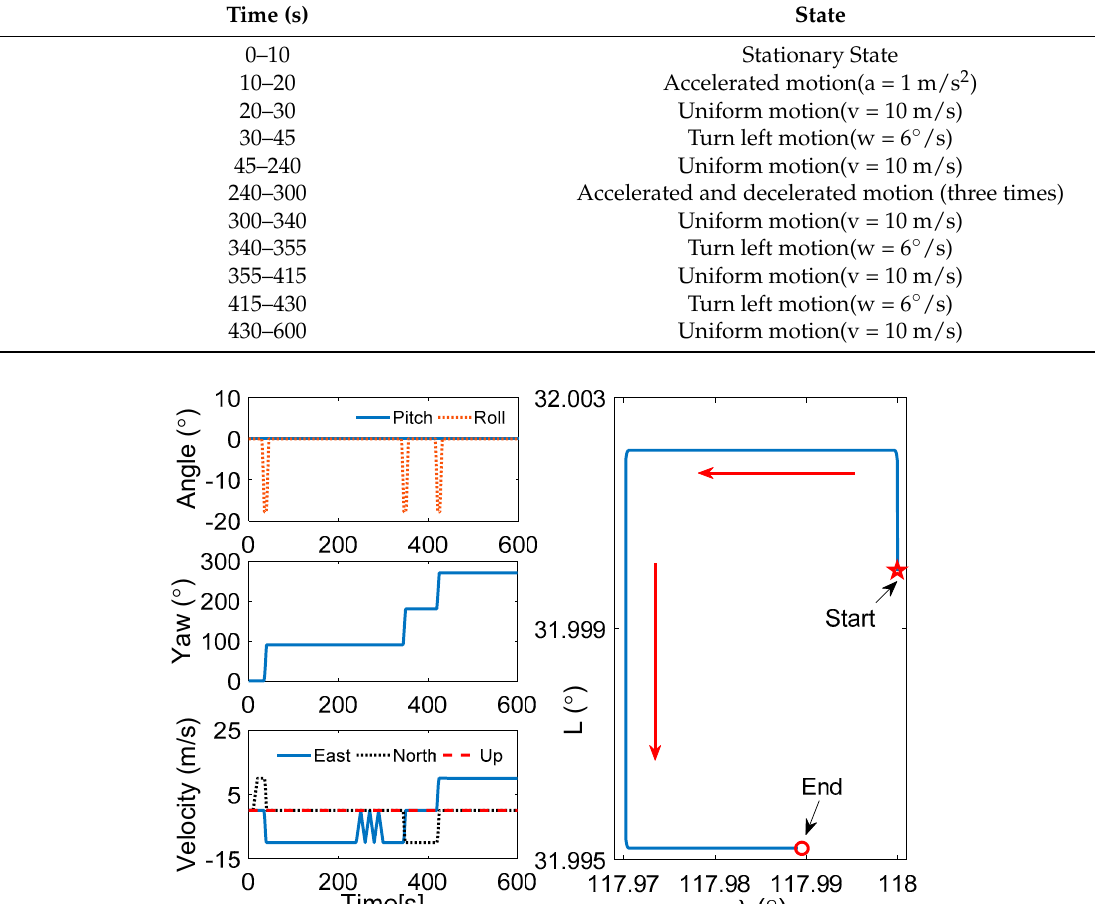
Table 5. The process of the vehicle motion.